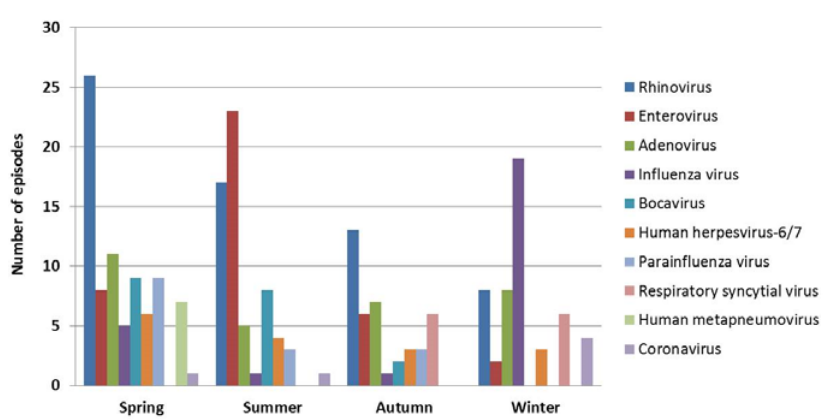
Figure 1. Seasonal distributions of respiratory viruses in children with febrile seizures.